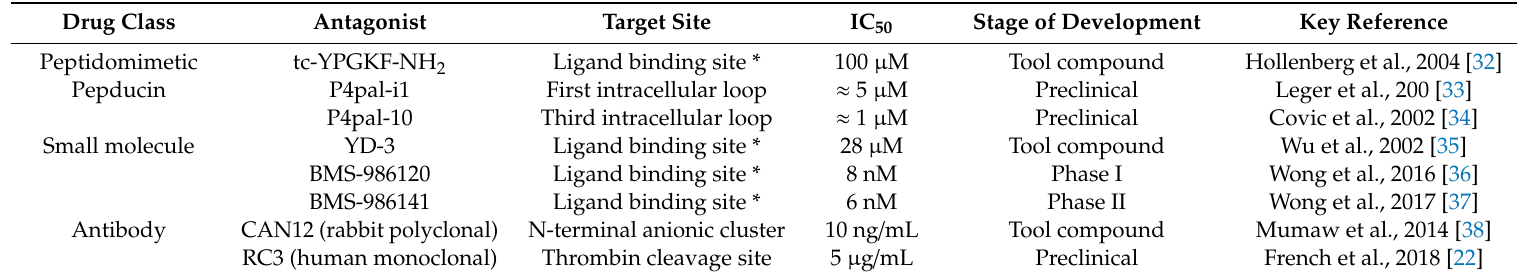
Table 1. Major PAR4 inhibitors and their mode of